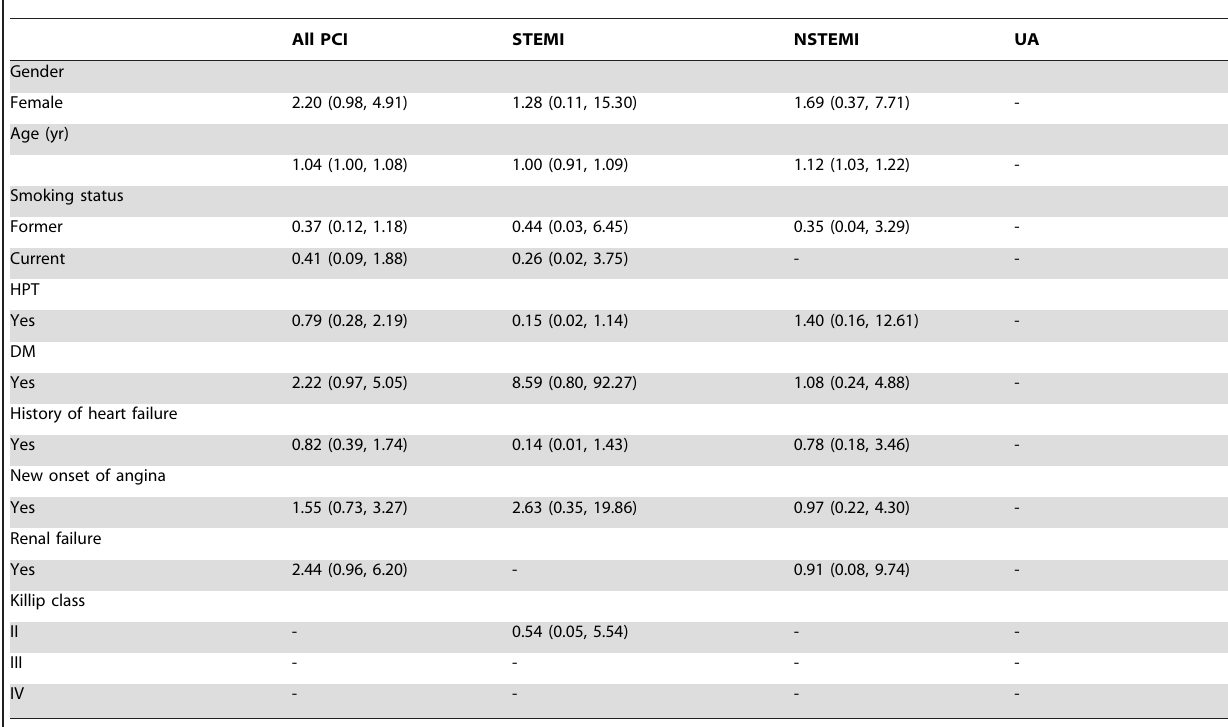
Table 9. Risk of mortality at 6 months for total